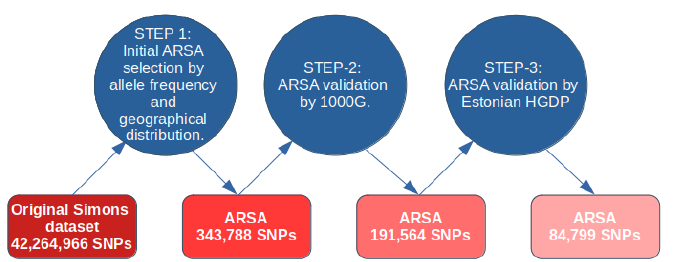
Figure 1. Legend: Computational methodology for characterization of ARSA SNPs with three validation points.